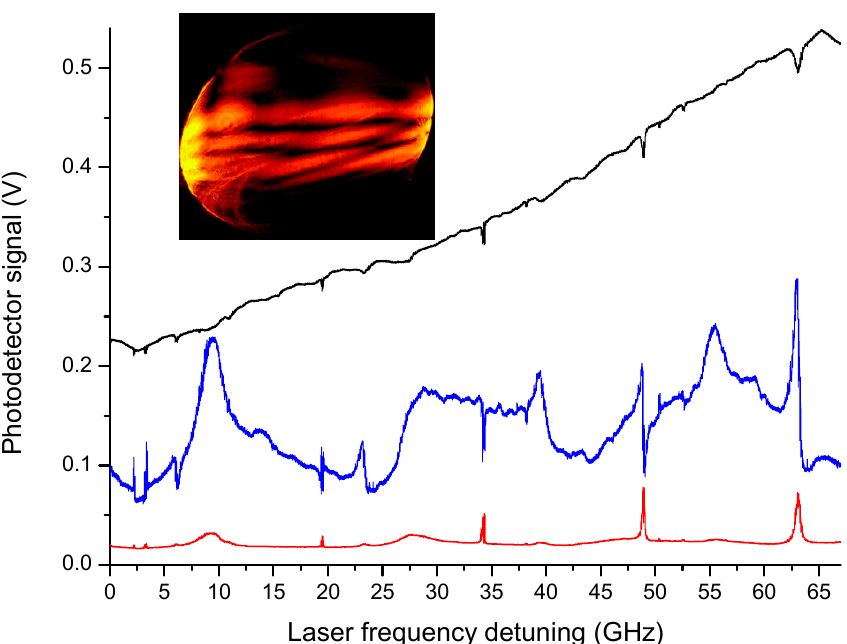
Figure 3. Whispering gallery mode (WGM) resonances recorded from the transmission (black line), back-scattering (red) and side-scattering (blue) of a pendant liquid paraffin droplet excited by a 640-nm laser beam with incident power of 5 mW. The observed coupling efficiency for the central mode is about 6%. In the inset, a camera view of the side scattered light evidences the presence of different WGMs.